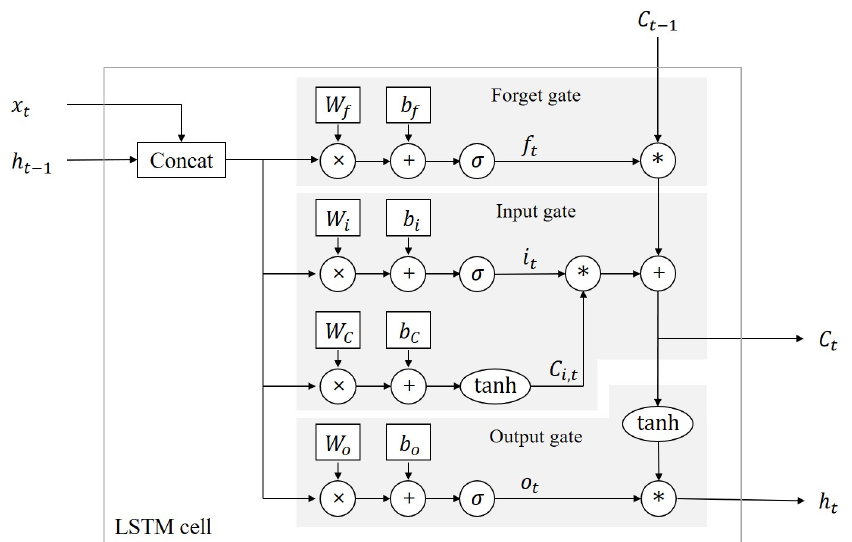
Figure 2. Structure of the LSTM